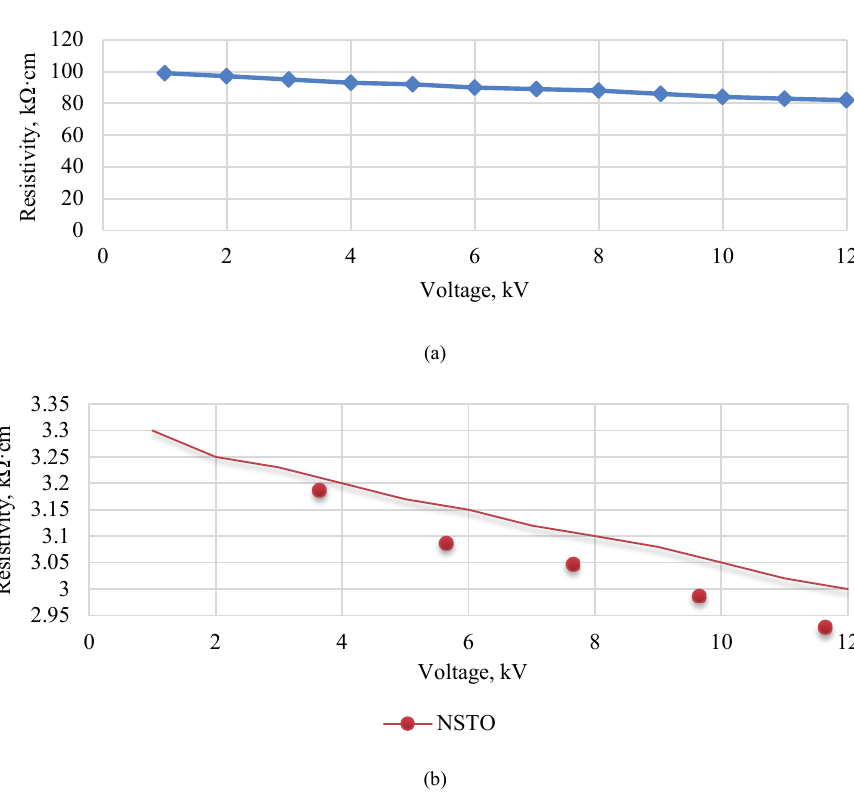
Fig. 4. Resistivity changes in relation to voltage: a) Mineral oil; b)